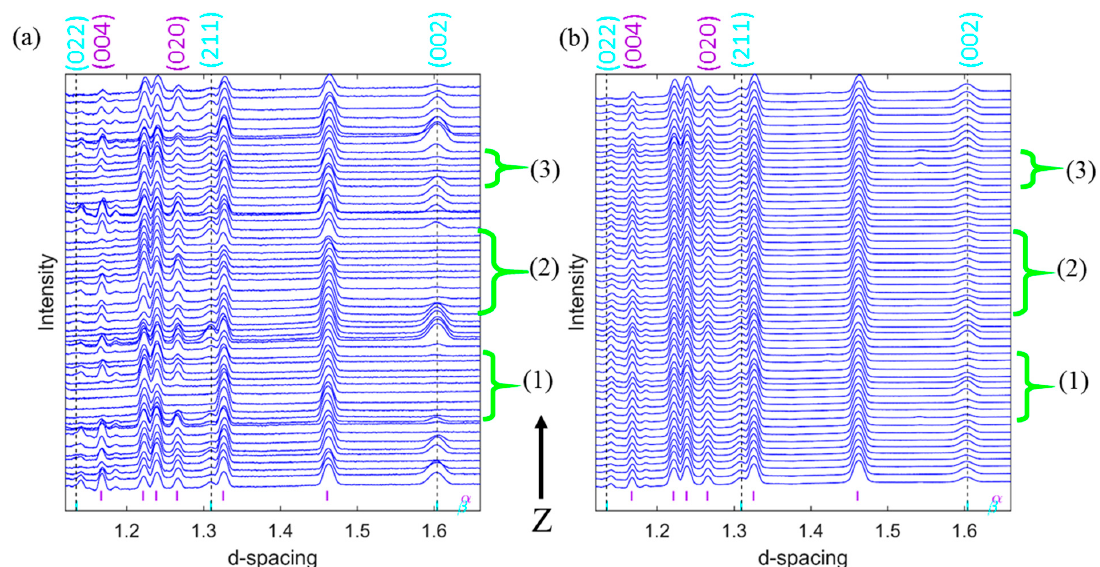
Figure 5. Assembled diffraction patterns of a vertical scan (along the build length) of one of the EBM Ti-6Al-4V samples (S7V). ( a ) is from the detector element 15 alone and ( b ) is the sum of all 23 elements of the same scan. The black arrow indicates the build direction from bottom to top.